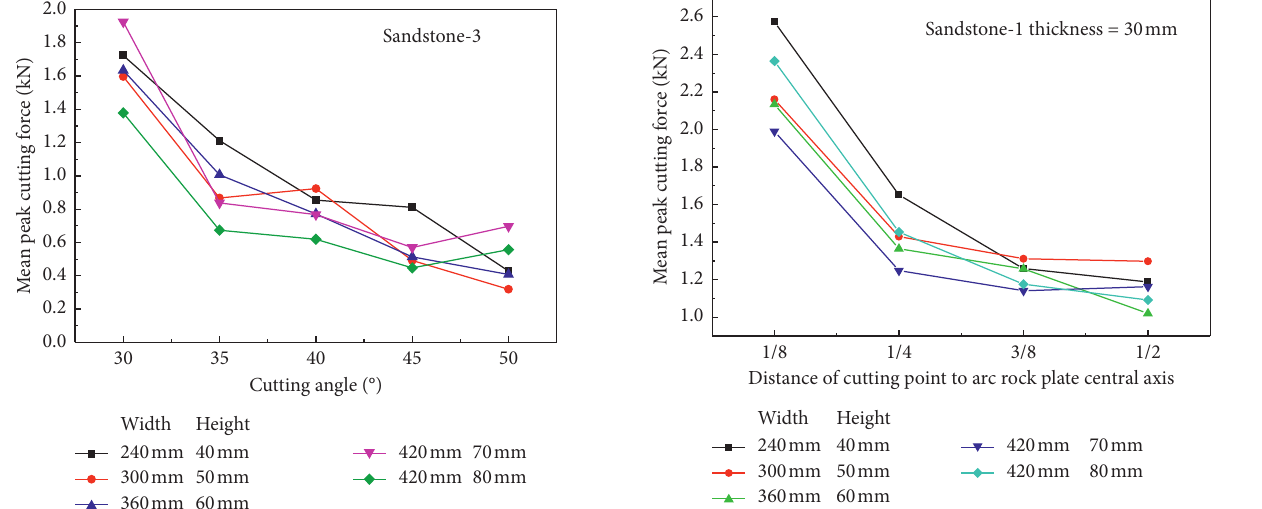
Figure 17: The variation of mean peak force with cutting point to arc rock plate central axis